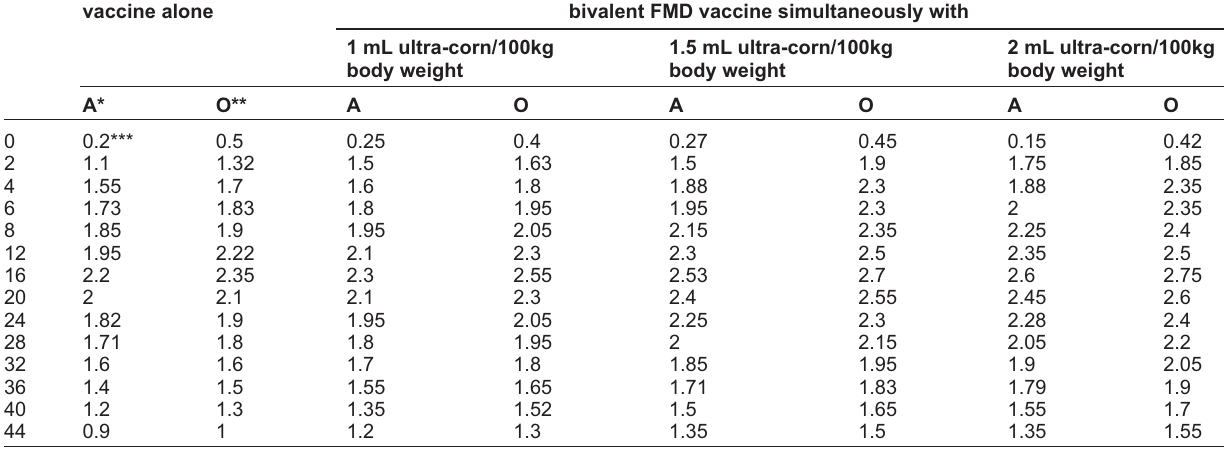
Table-1. Mean FMD serum neutralizing antibody titers in calves vaccinated with bivalent FMD with ultra-corn simultaneous (locality A) WPV calves receiving the